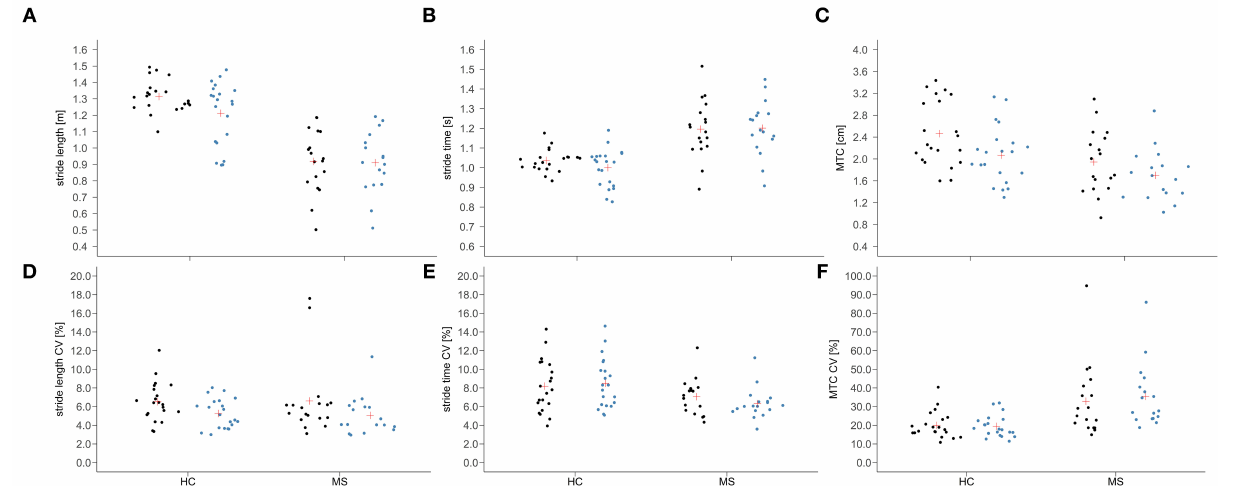
TABLE 1 | Spatio-temporal gait parameters recorded during dual-task walking before and after the fast 6MWT (mean ± standard deviation) and rmANOVA outcomes ( p -values and effect size partial eta ² ). Gait parameter Group